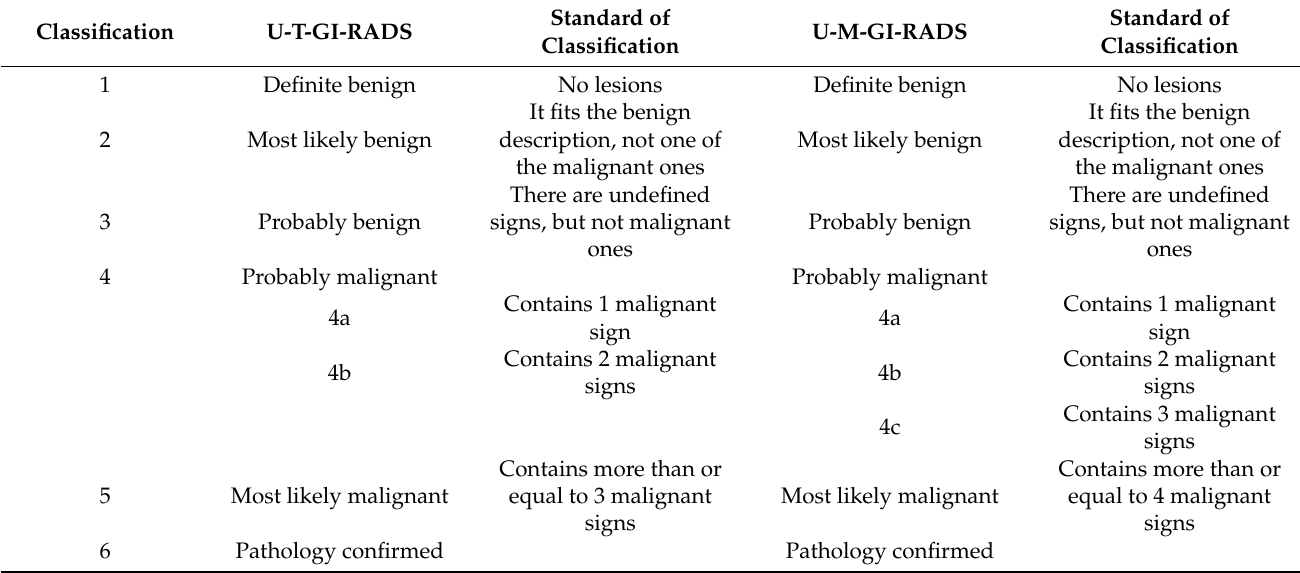
Table 4. Comparison of traditional and modified GI-RADS grading